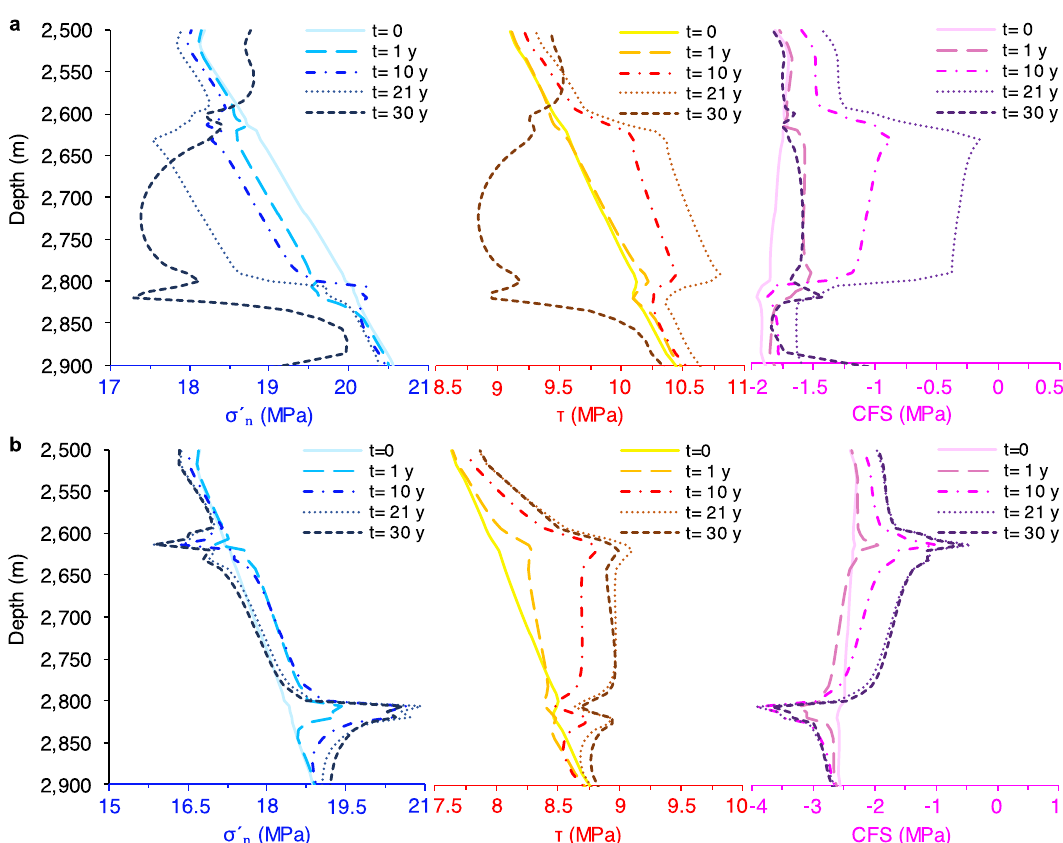
Figure 5. Temporal evolution of fault stability. Evolution with time of the effective normal stress, shear stress and CFS along fault 1 ( a ) and fault 2 ( b ). Colors in each panel gradually shift from light to dark, corresponding to the elapsed time from the circulation onset: Light to dark blue for the effective normal stress, yellow to brown for the shear stress, and light to dark violet for the